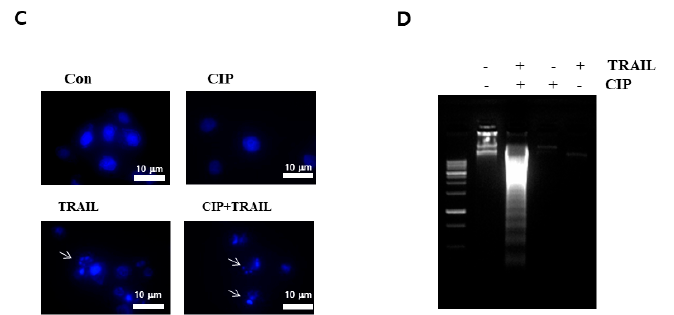
Figure 1. CIP enhanced TRAIL-induced A549 cell death. ( A ) Cells were pretreated with various concentrations of CIP for 20 h before exposure to TRAIL (10 and 50 ng/mL) for 4 h. Cell viability was analyzed by trypan blue exclusion assay. Data represent the mean ± SD of 3 samples. * p < 0.05 compared to the CIP + TRAIL-treated cells. ( B ) Cells were treated with TRAIL in the presence or absence of CIP for 24 h. After treatment, change in cell morphology was detected by light microscopy. Scale bar = 20 μ m. ( C ) Microscopic examination was performed to detect apoptosis by nuclear staining with DAPI. The images shown are representatives of three independent experiments. Scale bar = 10 μ m. ( D ) Cells were treated with TRAIL for 4 h in the presence or absence of CIP for 20 h. For analyzing DNA fragmentation, fragmented DNA was separated by using 1.5% agarose gel.